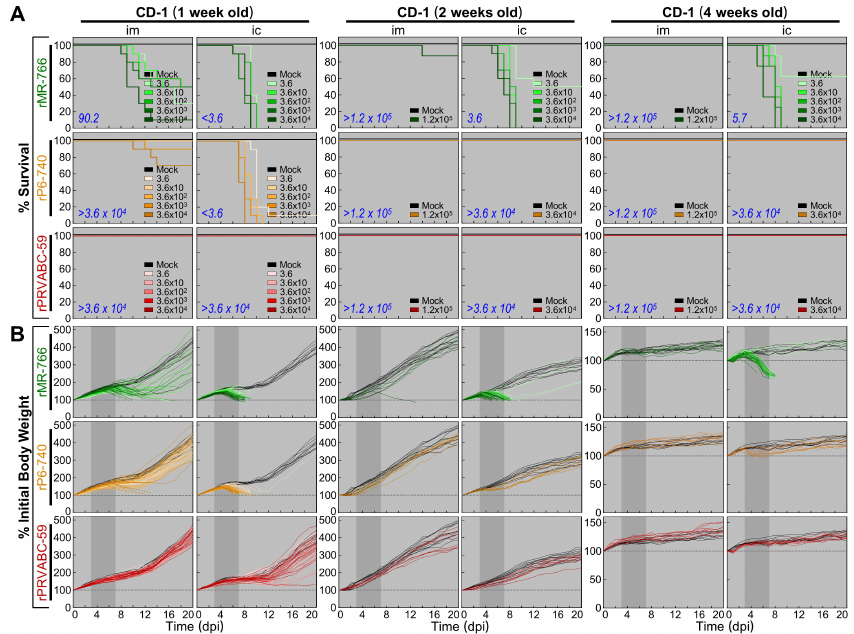
Figure 8. Three molecularly cloned ZIKVs display a full range of variation in neuropathogenicity for outbred CD-1 mice in an age-dependent manner. Groups of CD-1 mice ( n = 8–10, half male, half female) were mock-inoculated or inoculated at 1, 2, and 4 weeks of age via the intramuscular (im) or intracerebral (ic) route with a maximum dose of 3.6 × 10 4 or 1.2 × 10 5 PFU, or serial 10-fold dilutions of rMR-766, rP6-740, or rPRVABC-59. ( A ) Survival curves were generated by the Kaplan–Meier method, and LD 50 values were determined by the Reed–Muench method and are presented in the bottom left corner of each curve. ( B ) Weight changes are plotted, with each mouse represented by one color-coded line. dpi, days